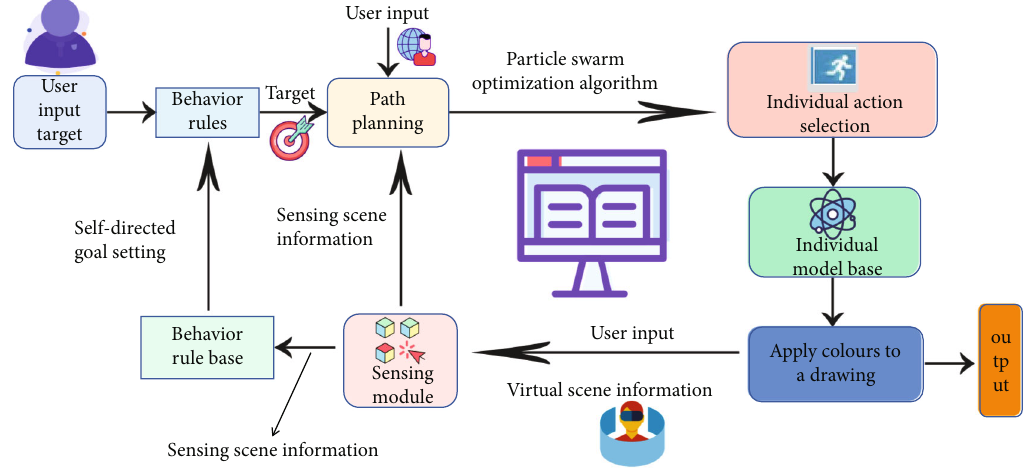
Figure 1: Group animation construction